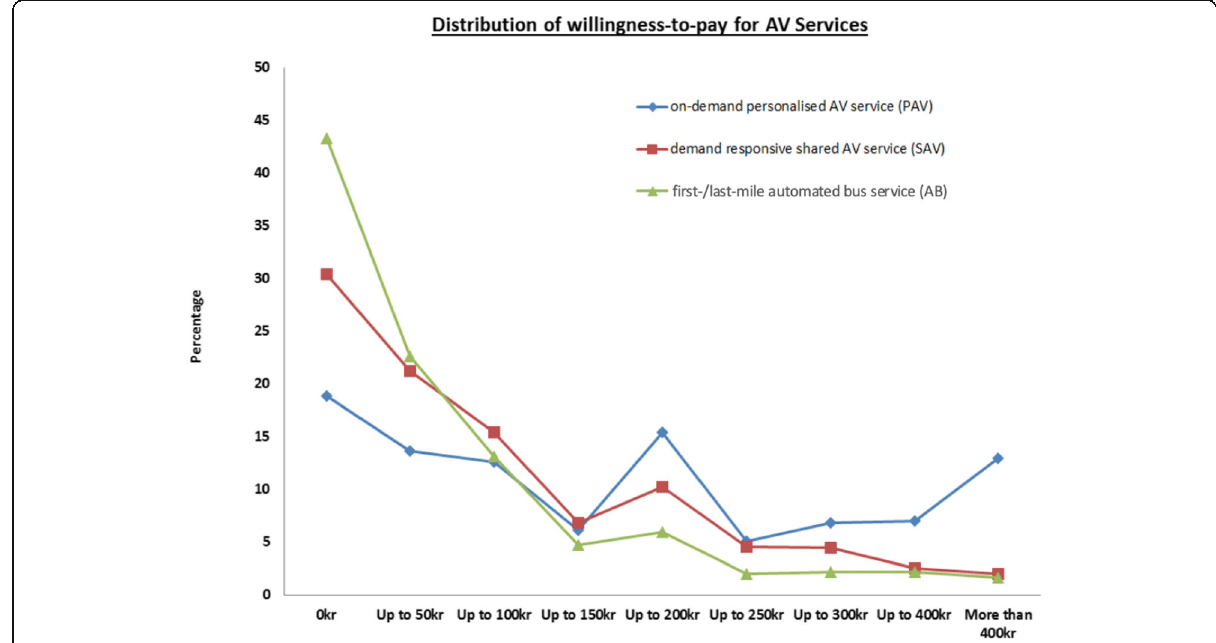
Fig. 4 Distribution of willingness-to-pay for three types of AV services (PAV, SAV and AB services)